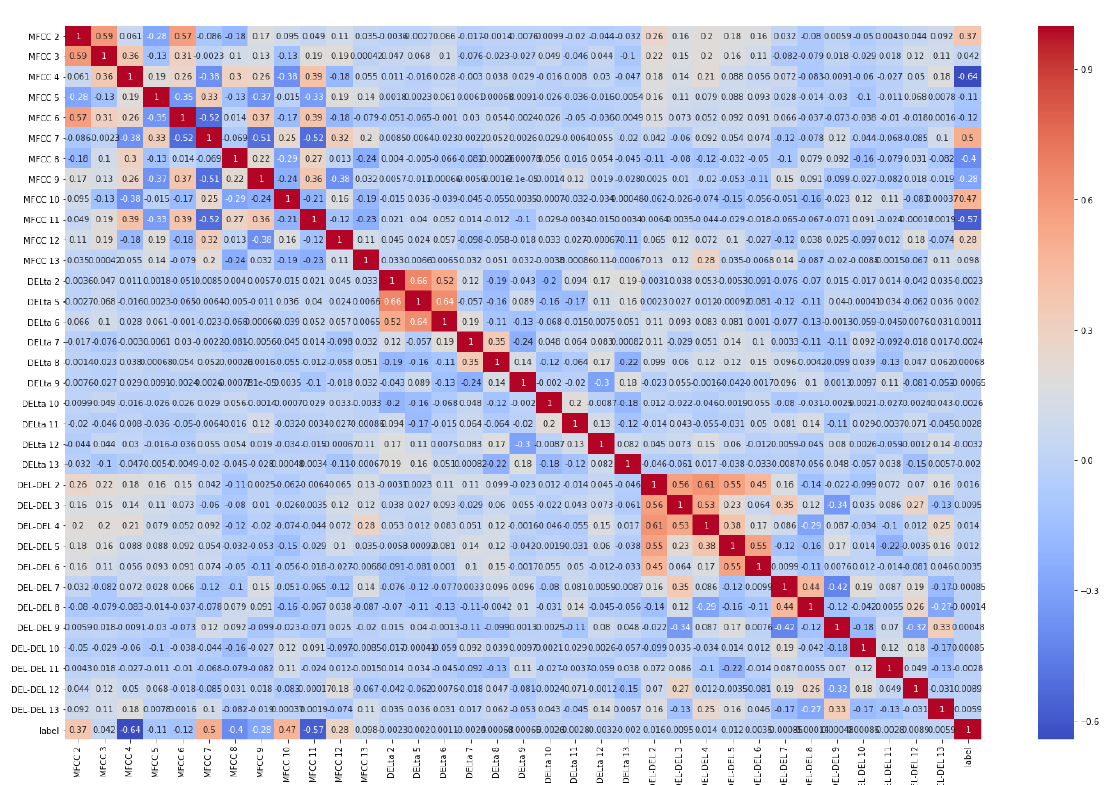
Figure A2. Correlation matrix of the 34–dimensional feature vector obtained by the filter–based feature selection process (Pearson’s correlation